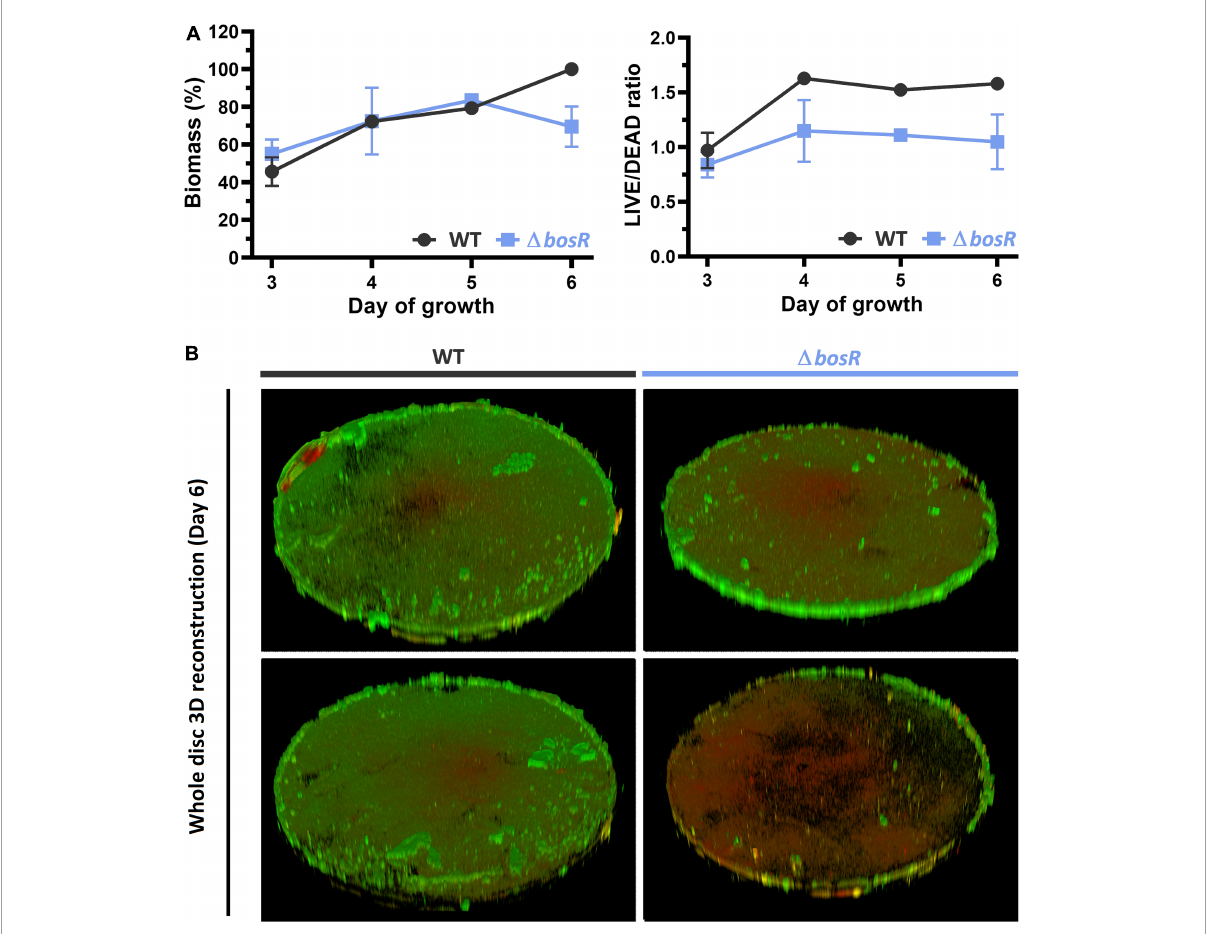
FIGURE4 Biofilm biomass and viability of WT and the bosR deletion mutant determined by CLSM. Six day-biofilms covering the entire HA disc were imaged with a 2.5 × objective using tiled Z-stacks after staining with Syto9 (green; live) and propidium iodide (red; dead). (A) The line plots show the average total biomass expressed as a percentage of the average WT biomass on day 6 (left) and the average LIVE/DEAD ratio (right) . (B) 3D reconstruction of the whole-disc Z-stacks used for